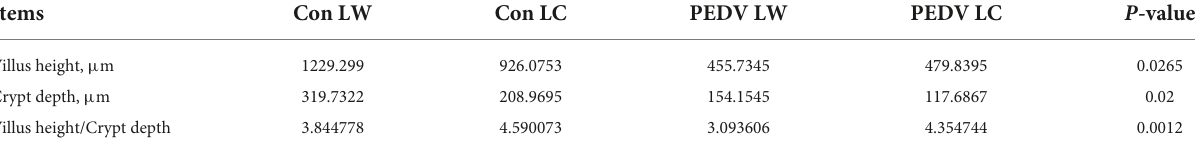
TABLE 6 Effects of porcine epidemic diarrhea virus on jejunal morphology of piglets.